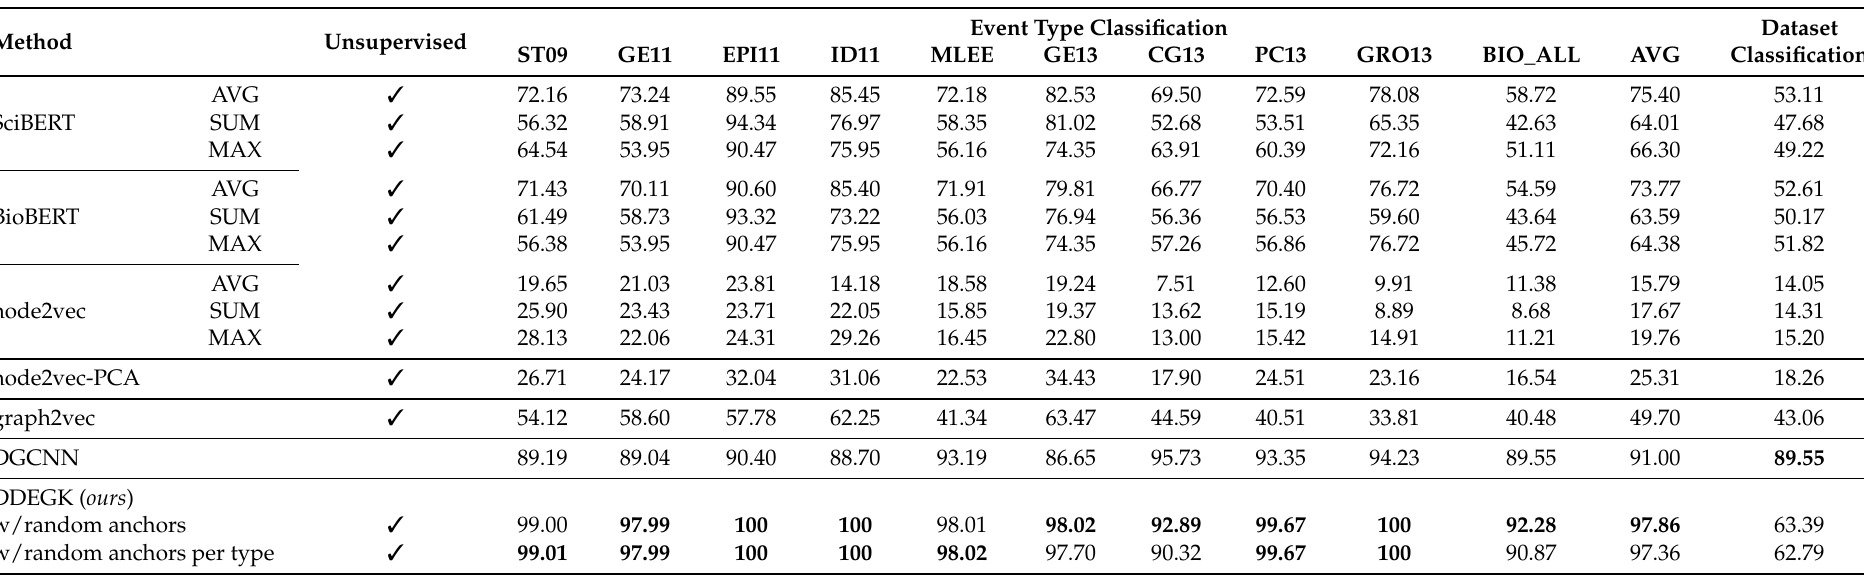
Table 3. Average accuracy (support-weighted F1-score) in ten-fold cross validation on event type and dataset classification tasks. Methods are grouped by